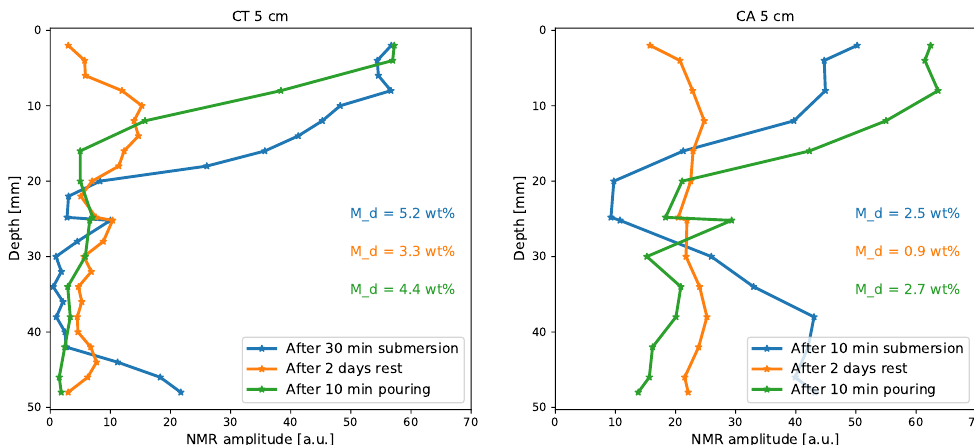
Figure 5. NMR measurements showing the depth-resolved moisture distribution during the satura- tion process of the 5 cm CT ( left ) and CA ( right ) screed.